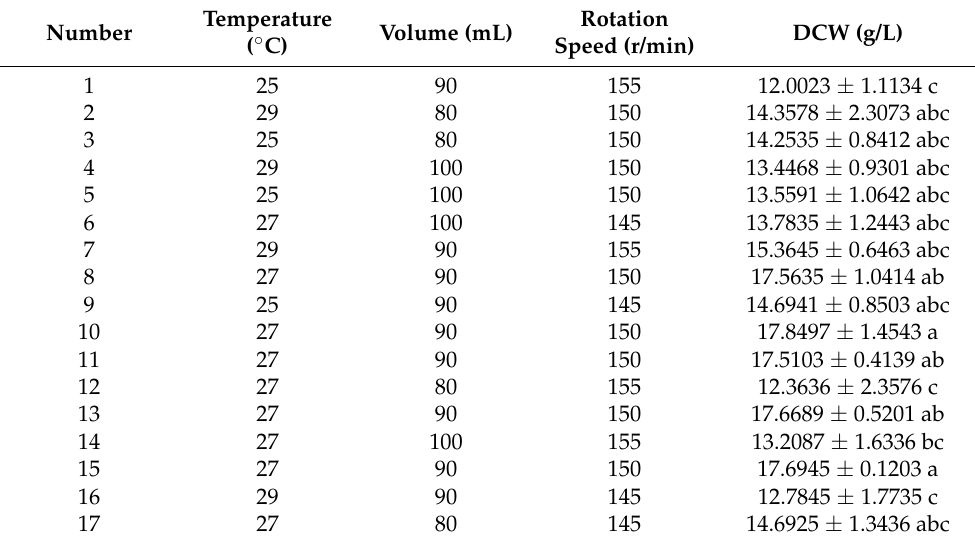
Table 4. Experimental design and results of response surface